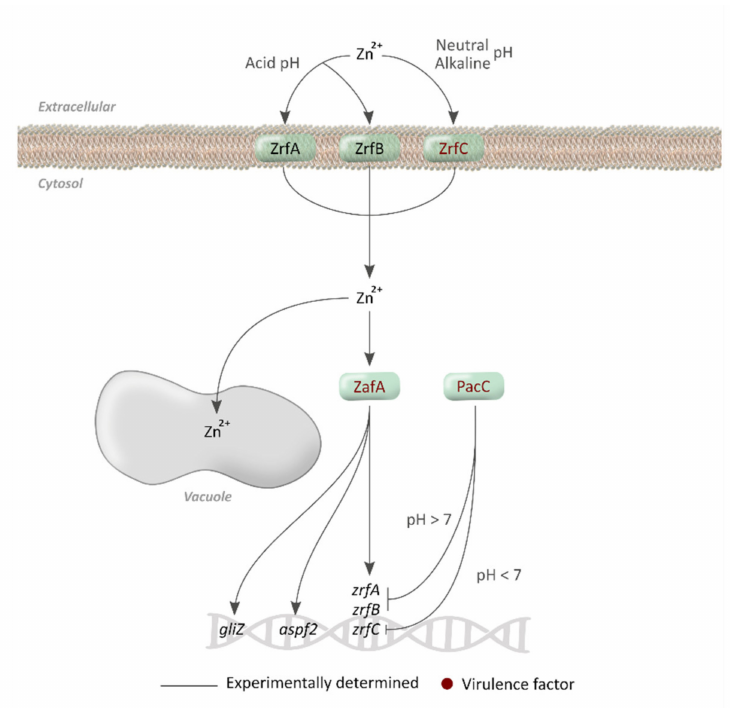
Figure 4. Zinc sensing, uptake, metabolism, and regulation in A. fumigatus . Zinc enters the cytosol through ZrfA or ZrfB at acid pH or through ZrfC in neutral to alkaline conditions. It is stored in vacuoles. ZafA TF overexpresses zrfA, zrfB and zrfC genes in Zn-depleted conditions and PacC inhibits zrfA/B in alkaline conditions and zrfC in acid